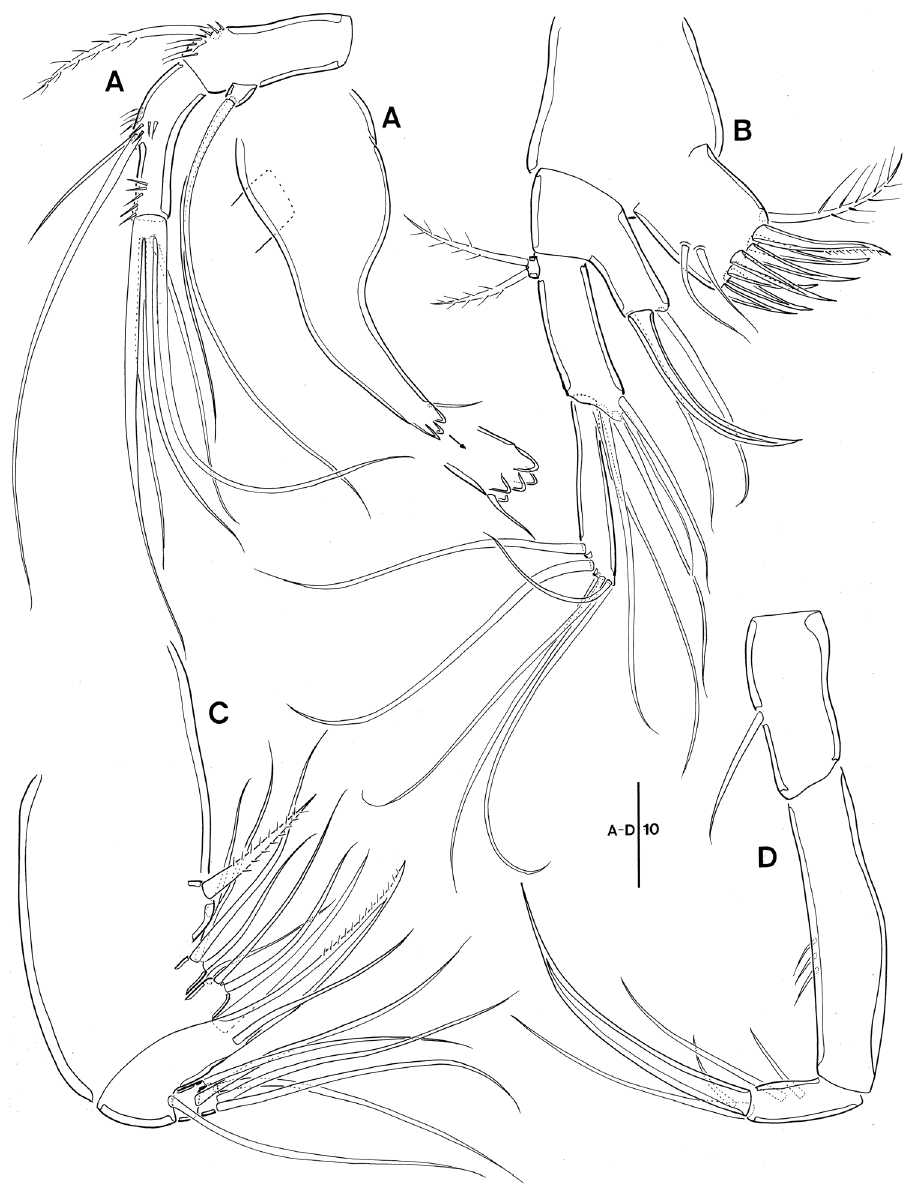
Figure 7. Leptopsyllus ( Leptopsyllus ) koreanus sp. n. ( ♂ ). A B maxillule C maxilla D maxilliped. Scale bars are in